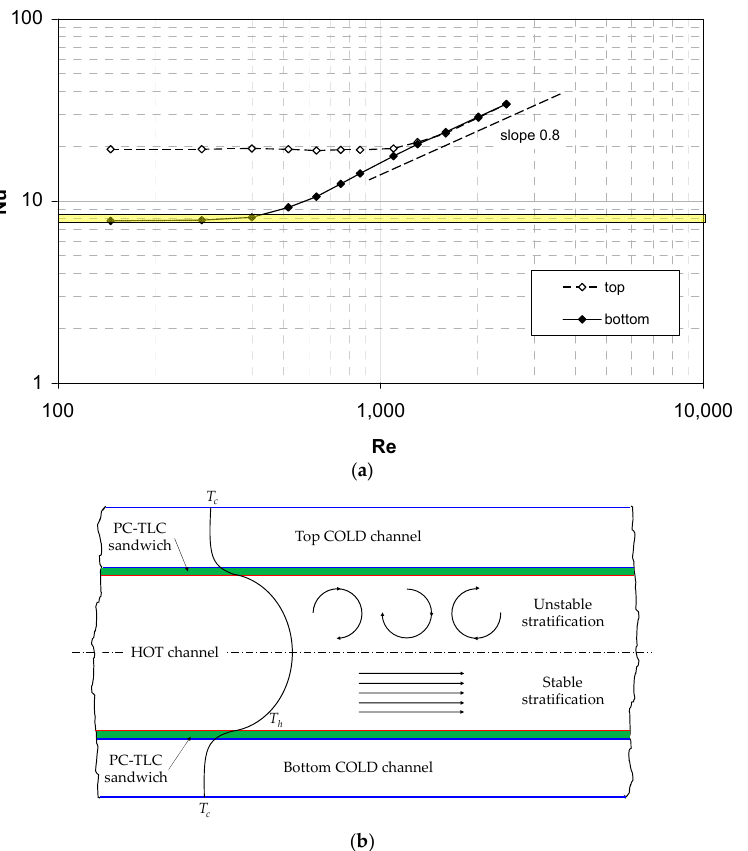
Figure 6. ( a ) Experimental mean Nusselt number as a function of the Reynolds number on the top and bottom walls of the test section in the case of no spacer, showing the influence of buoyancy. The shaded area represents the expected range of Nu in the absence of buoyancy (7.54–8.34). ( b ) Schematic representation of the temperature distribution in the hot channel, with unstable stratification in its upper half and stable stratification in its lower half.